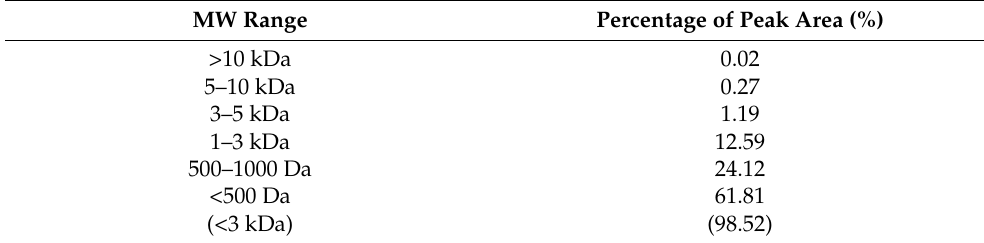
Table 1. Molecular Weight Distribution in